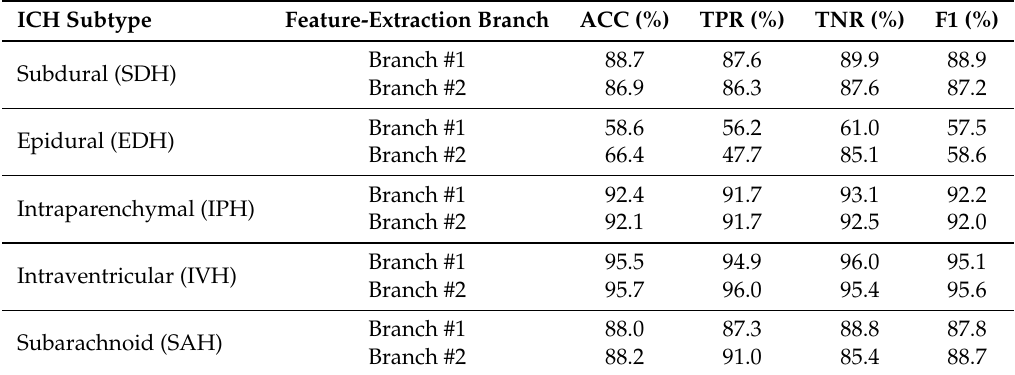
Table 2. Summary of evaluation metrics obtained in Experiment #1 for individual ICH subtypes and ResNet models.